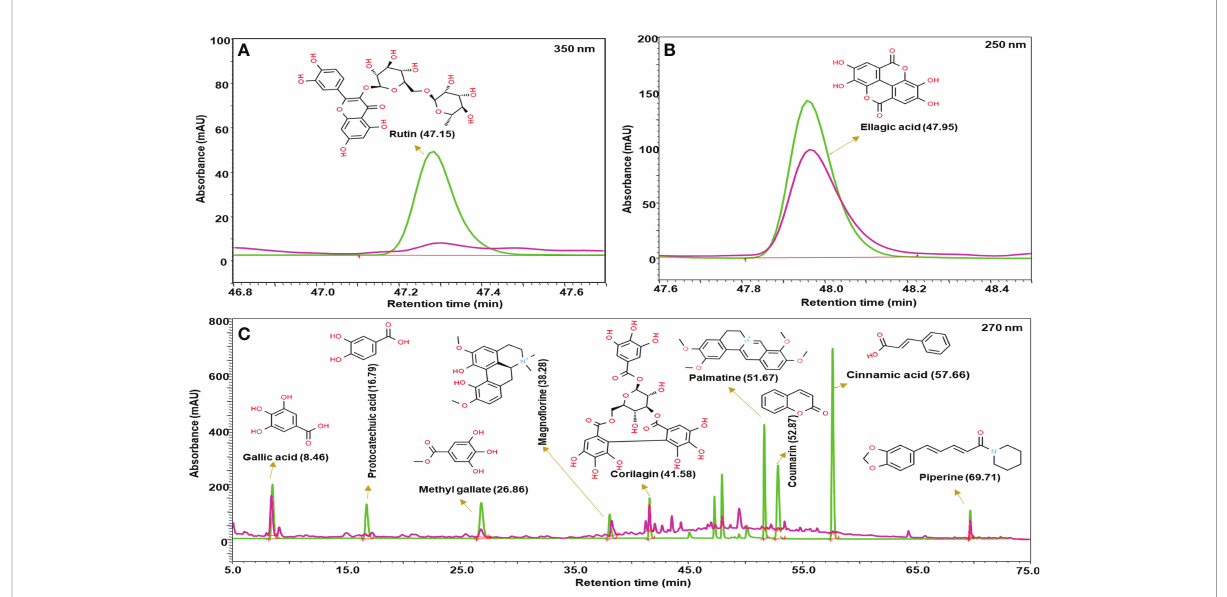
FIGURE 2 Phytometabolite analysis of Madhugrit by HPLC. Overlap chromatogram of standards (green line) and Madhugrit (pink line). Rutin was quanti fi ed at 350 nm (A) , Ellagic acid at 250 nm (B) , and Gallic acid, Protocatechuic acid, Methyl gallate, Magno fl orine, Corilagin, Palmatine, Coumarin, Cinnamic acid, and Piperine at 270 nm wavelength (C) .